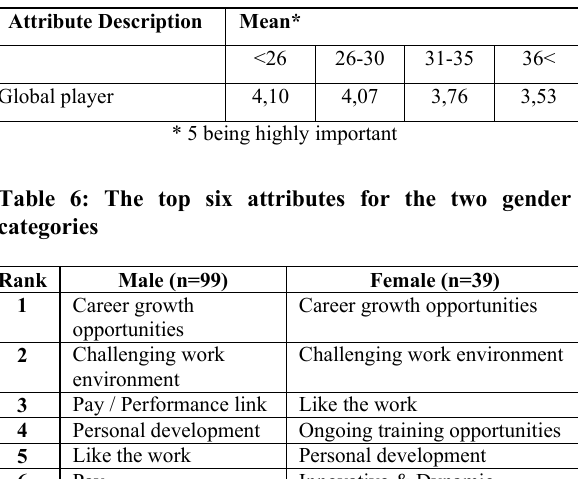
Table 5: The significant differences between the four age